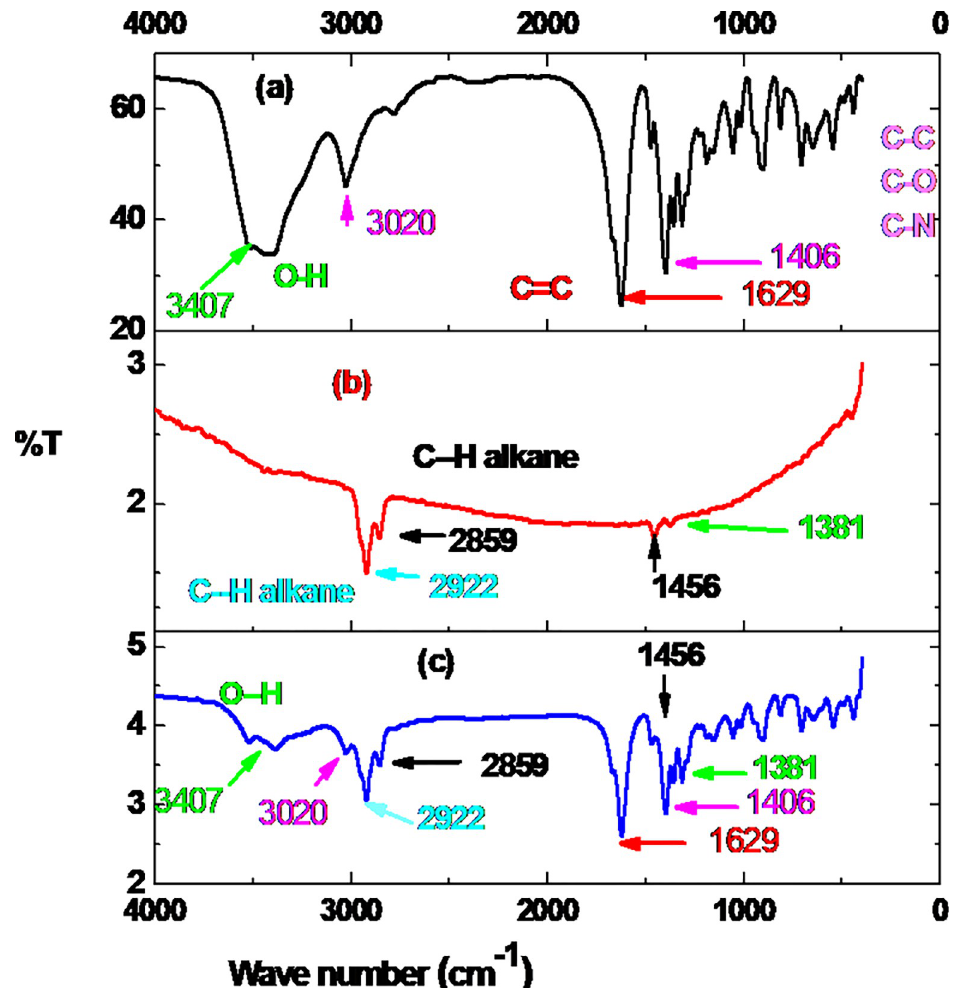
Fig 3. FT-IR spectra of (a) EDTA salt, (b) CPE, and (c) MCPE.